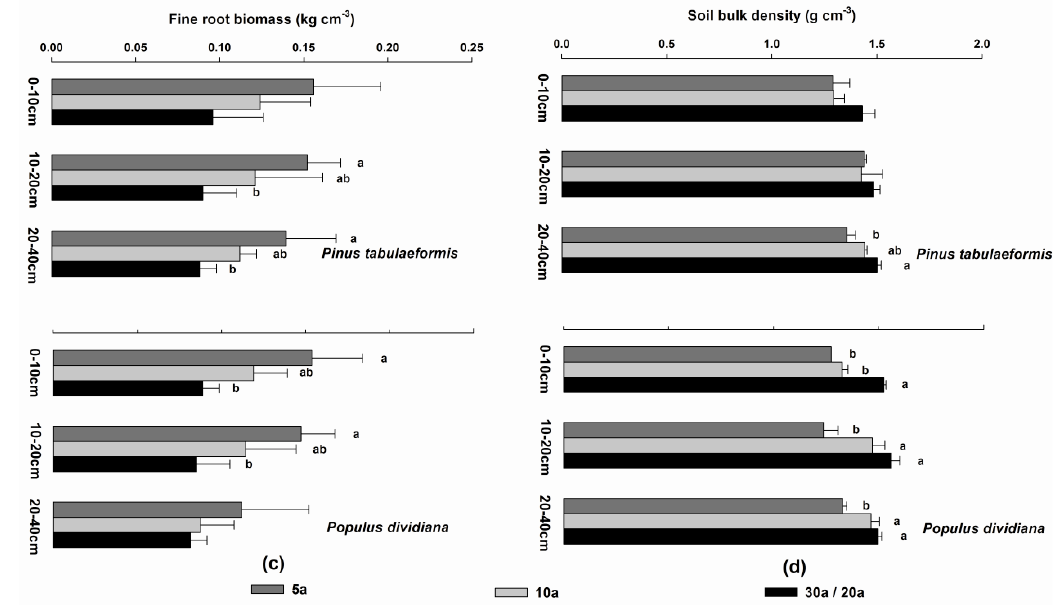
Figure 4. Soil organic carbon ( a ); soil total nitrogen ( b ); fine root biomass ( c ); and soil bulk density ( d ) at three different depths (0–10, 10–20, and 20–40 cm) in P. tabulaeformis and P. davidiana plantations. Different lowercase letters indicate a significant difference between the stand ages within the same soil depth. Bars indicate standard errors.